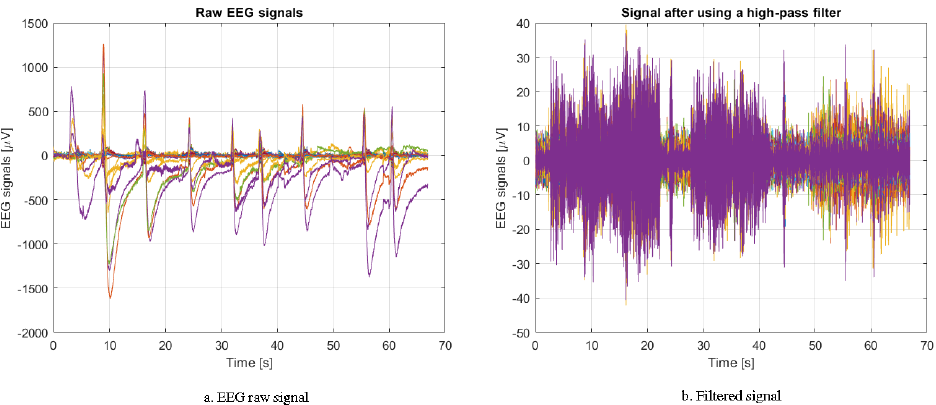
Figure 5. The observation of raw and filtered EEG